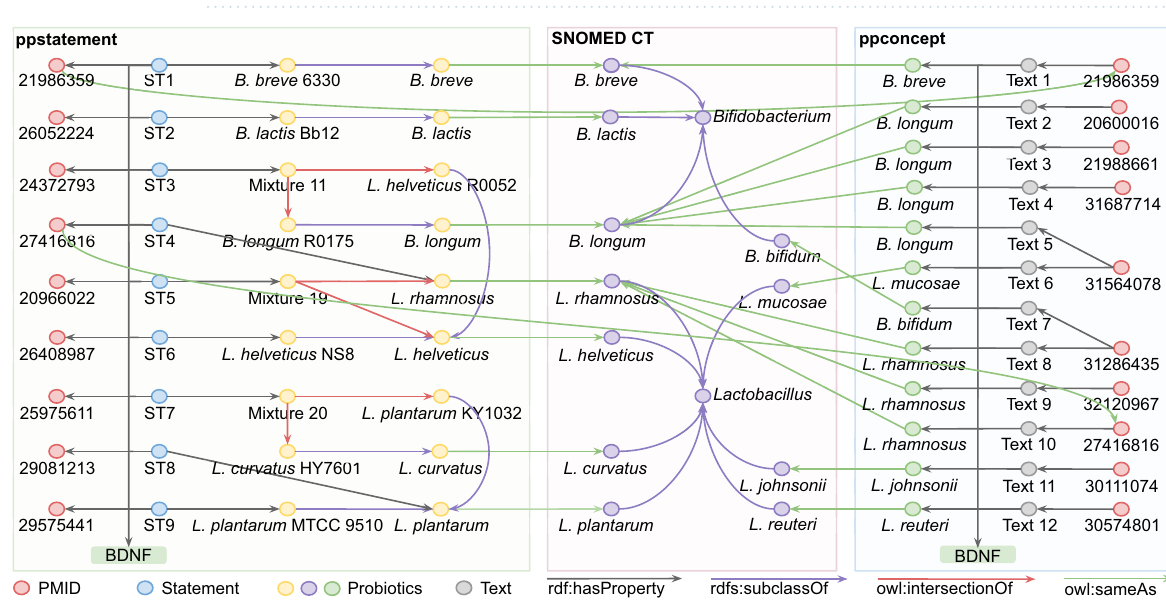
Figure 9. The returned relations between probiotics and the BDNF by query case 3, and the code is provided in SI Listing 3. Arrows indicate the direction of relations from source to